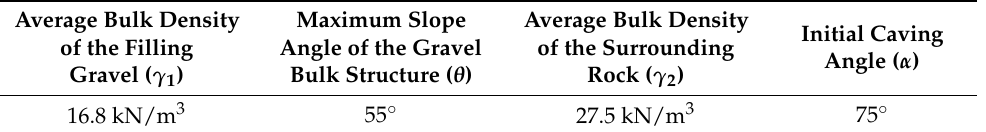
Table 1. The parameters of the mechanical model under open-pit and underground caving combined mining in the Dahongshan Iron